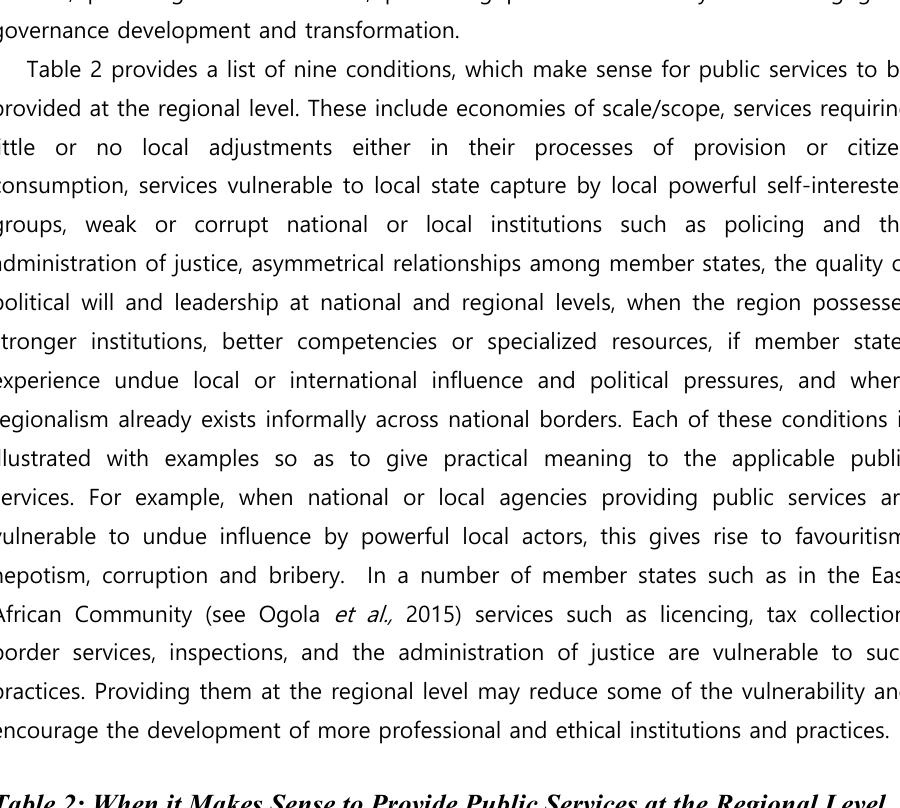
Table 2: When it Makes Sense to Provide Public Services at the Regional Level